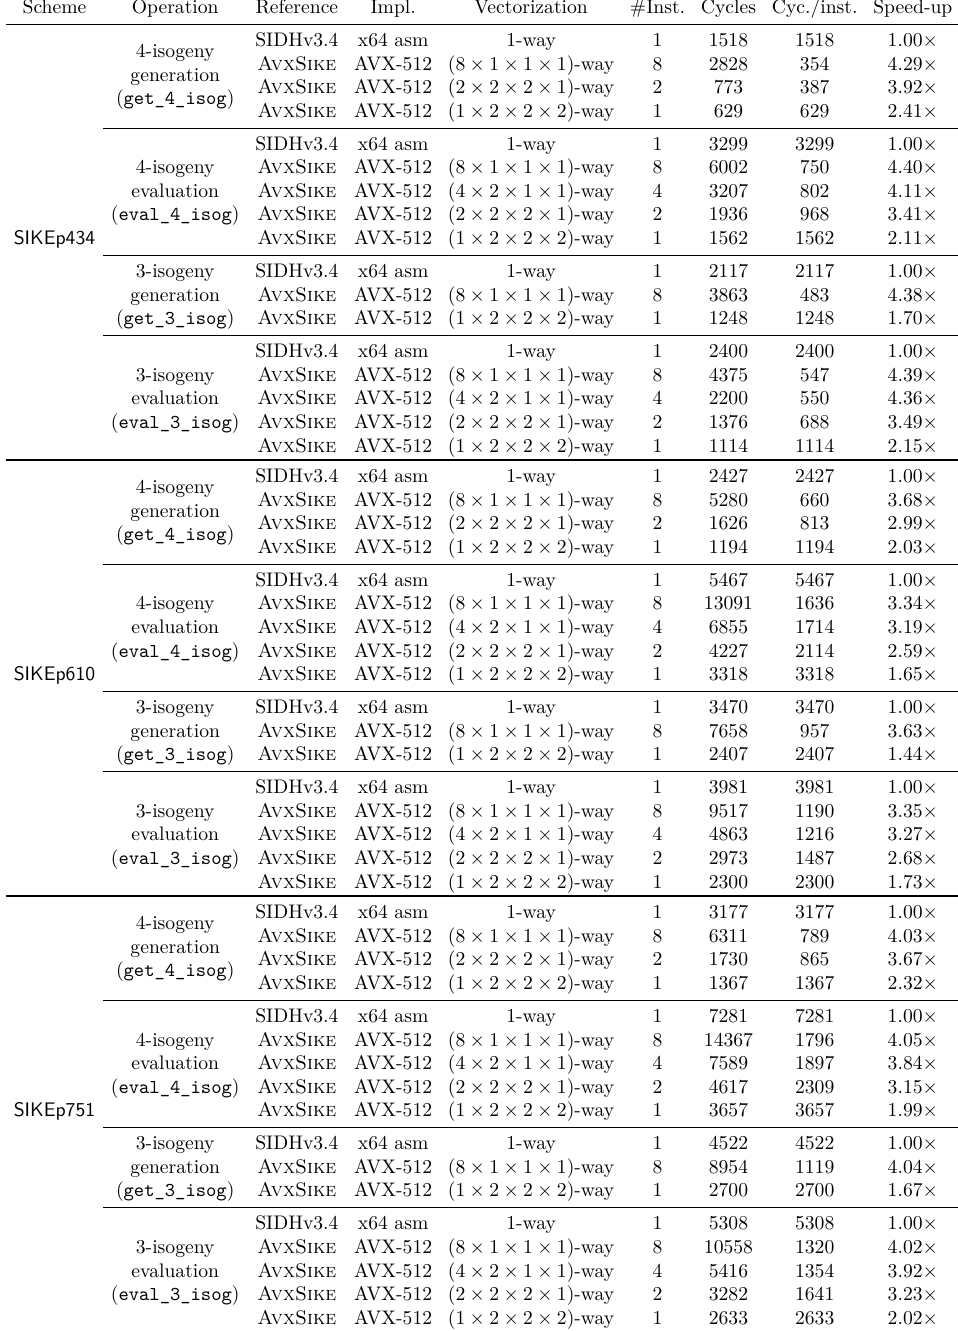
Table 10: Benchmarking results of implementations of isogeny operations.